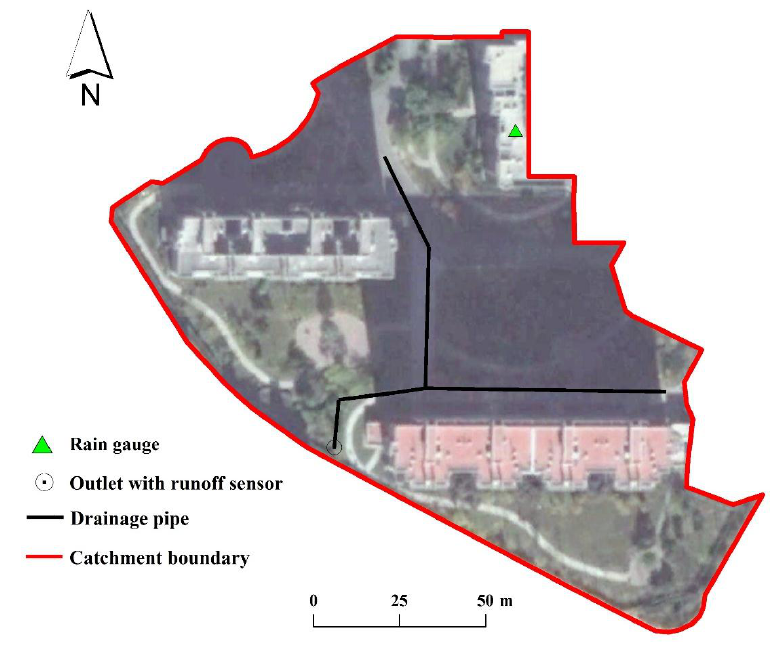
Figure 4. Catchment for rainfall-runoff monitoring in this study. Table 2. Calibrated parameter values for the Storm Water Management Model (SWMM).